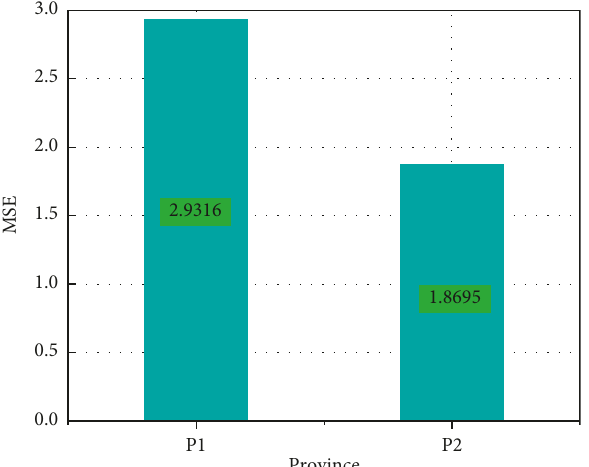
Figure 11: MSE between the predicted and real public acceptance in two provinces.